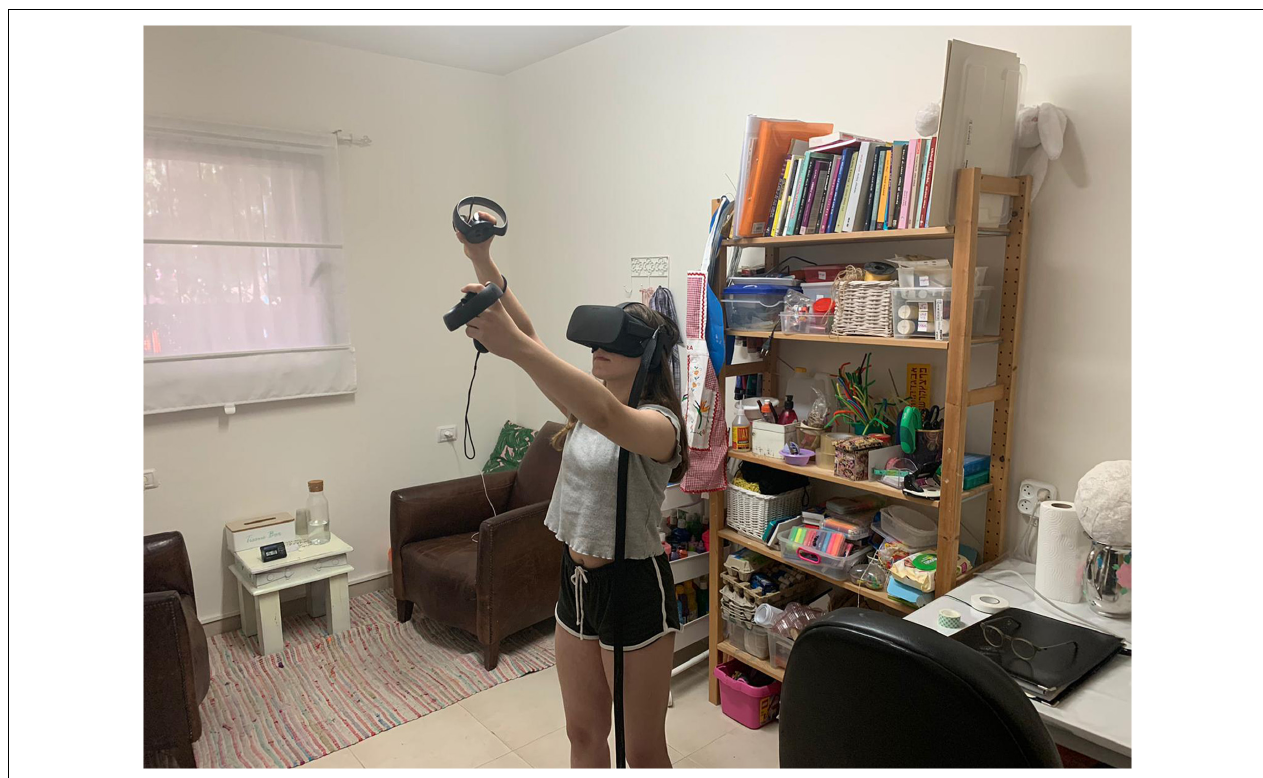
FIGURE 1 | The setting and therapeutic space are influenced by the VR’s creative